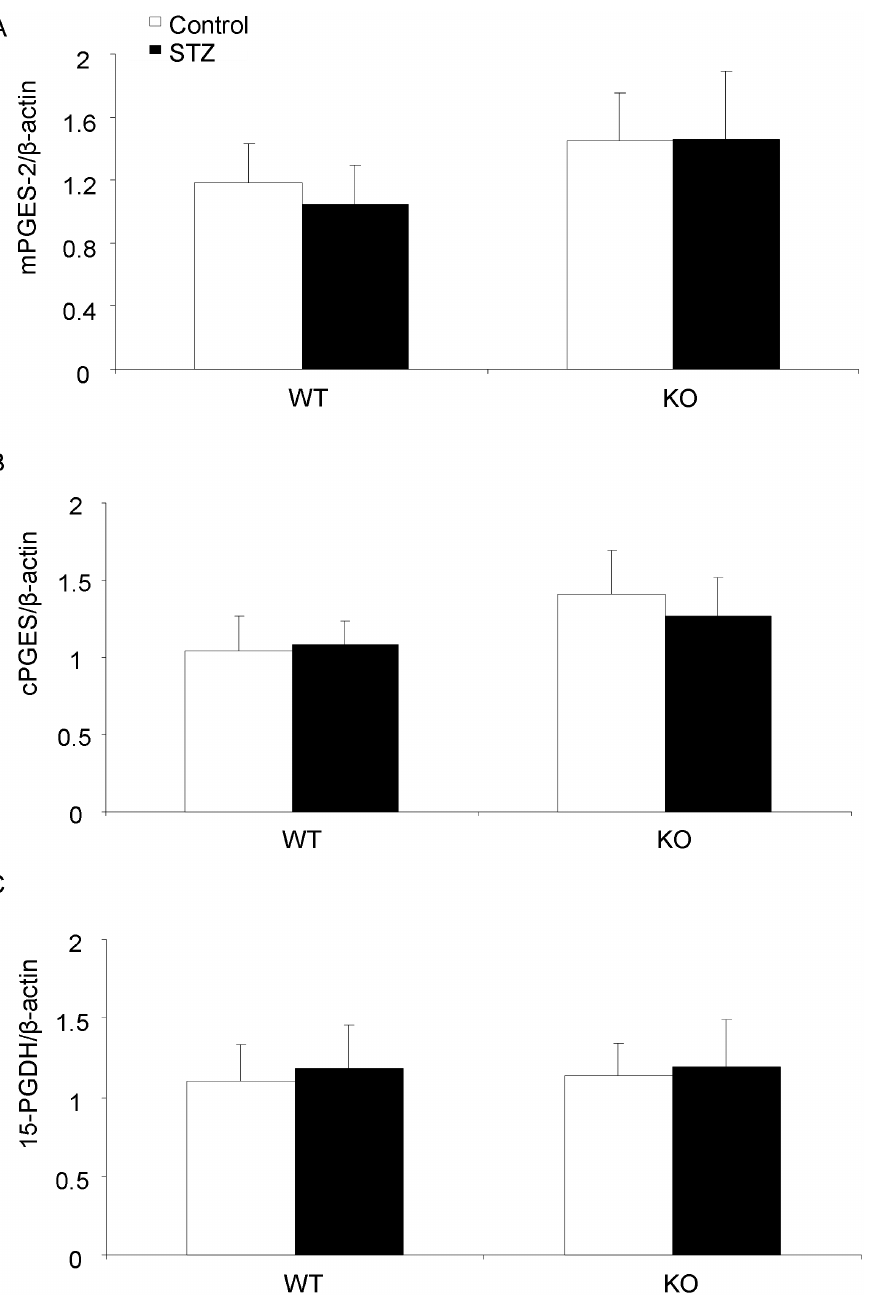
Figure 6. mRNA expressions of mPGES-2, cPGES and 15-PGDH in diabetic mice. (A) mPGES-2 mRNA expression by qRT-PCR (N=6–9 per group). (B) cPGES mRNA expression by qRT-PCR (N=6–9 per group). (C) 15-PGDH mRNA expression by qRT-PCR (N=6–9 per group). Data are mean 6 SE.